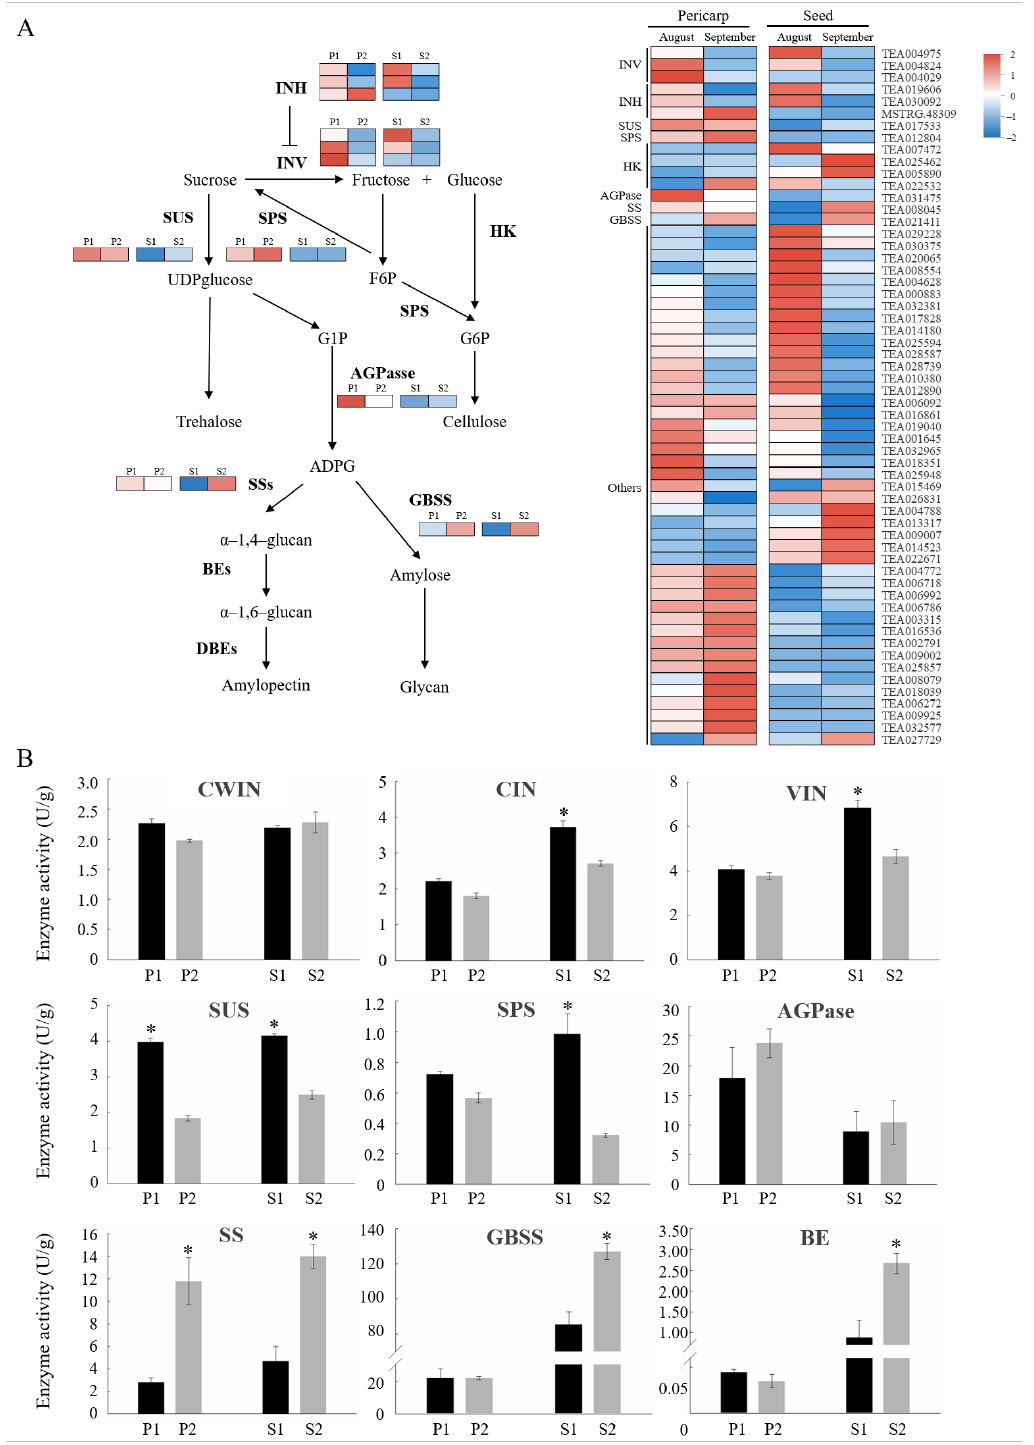
Figure 7. Expression pattern and enzyme activity of DEGs from the ‘Starch and sucrose metabolism’ pathway in oil tea. ( A ) Regulatory network of sucrose and starch metabolism underlying the DEGs in pericarp and seeds. Expression patterns of DEGs included in ‘Starch and sucrose metabolism’ pathway are shown in heatmap. ( B ) Enzyme activity of DEGs involved in sugar metabolism in oil tea fruit. Bars represent the mean value ± SE ( n ≥ 5). The asterisk ( p ≤ 0.05) indicates significant differences between two unloading stages. P1: pericarp in August; P2: pericarp in September; S1: seeds in August; S2: seeds in